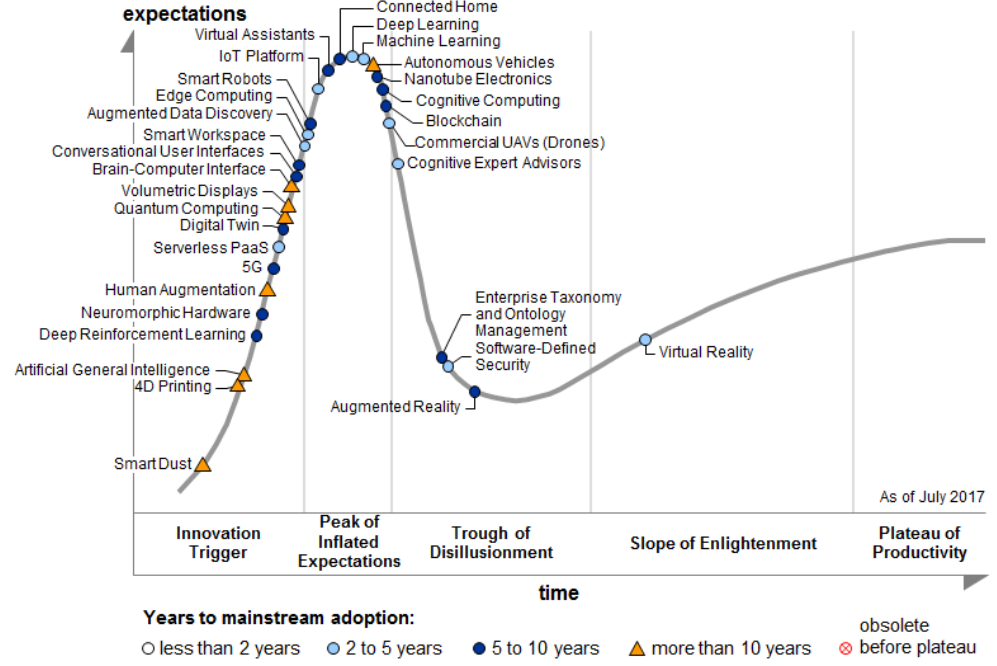
Figure 18. Gartner Hype Cycle of Emerging Technologies 2017. Source: Gartner